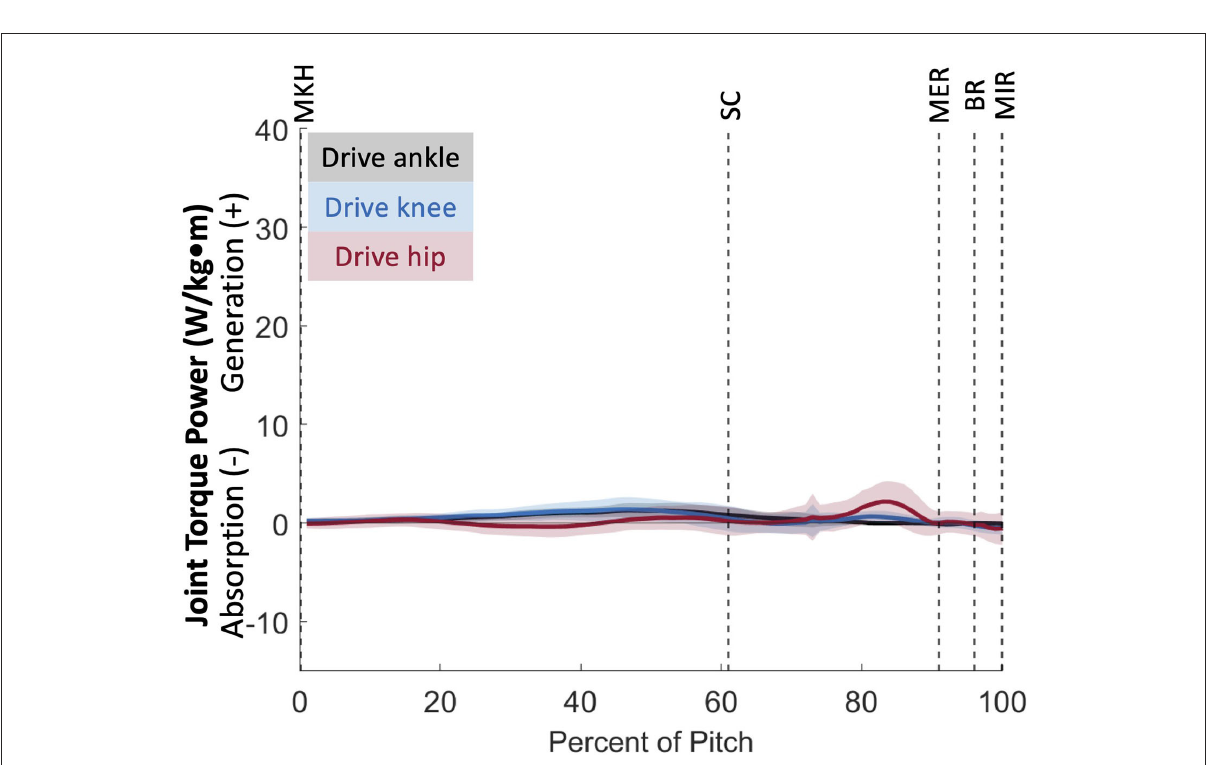
FIGURE4 Mean ± SD joint torque power for the joints of the drive leg (black = ankle, blue = knee, red = hip) for the duration of the pitch from maximum knee height (MKH) to maximum internal rotation (MIR).